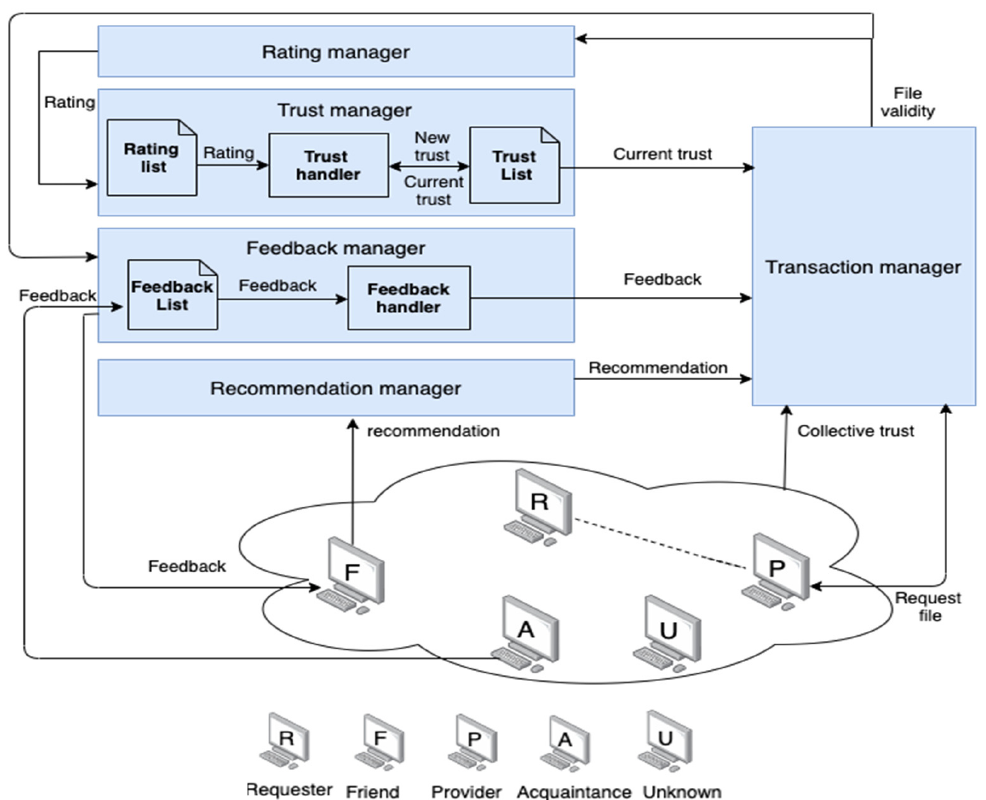
Figure 2. System architecture.